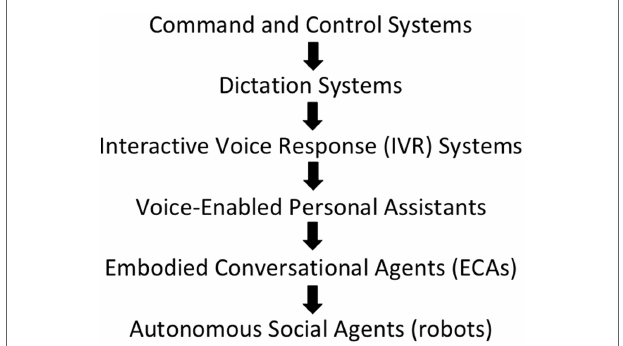
FIGURE 1 | The evolution of spoken language technology applications from specialised military ‘command-and-control’ systems of the 1980/90s to contemporary ‘voice-enabled personal assistants’ (such as Siri ) and future ‘autonomous social agents’ (such as robots).